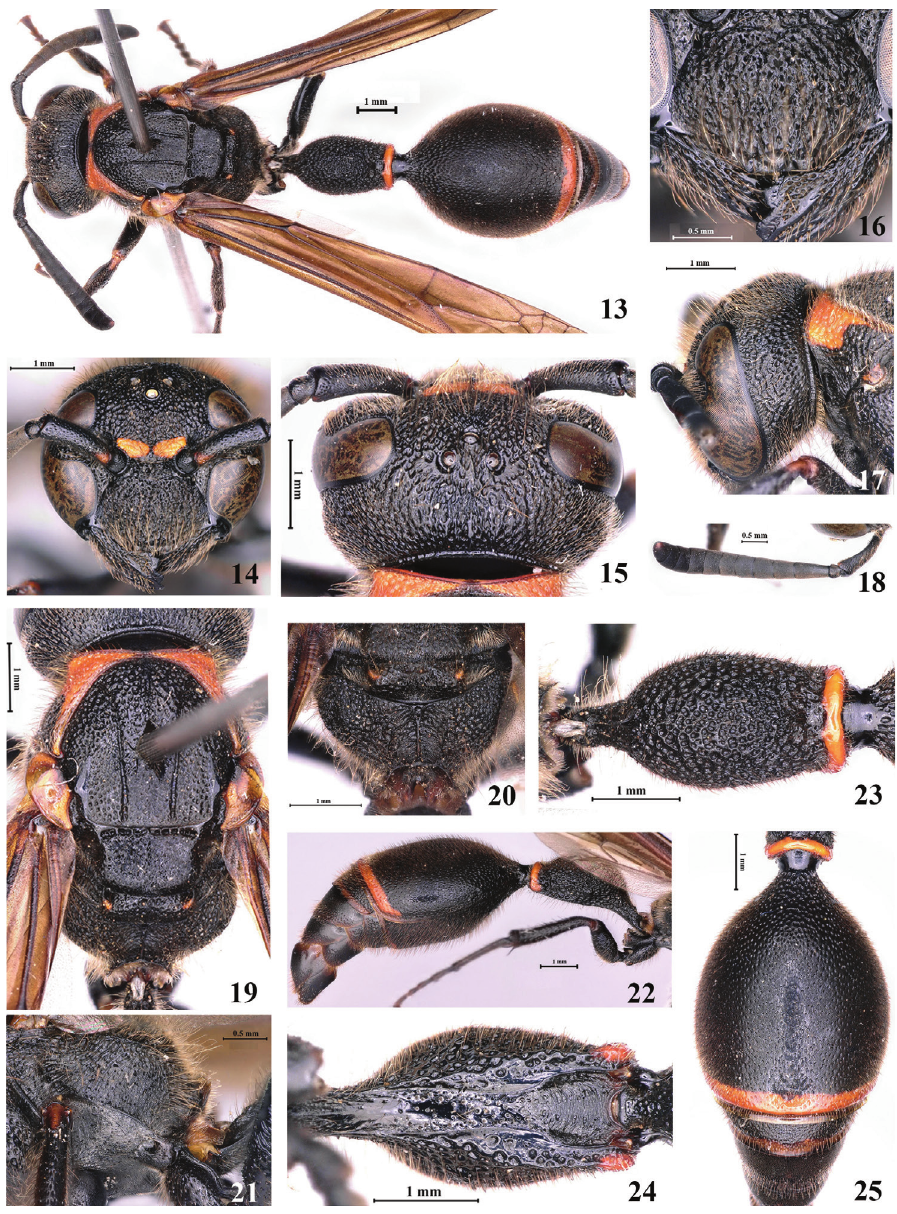
Figures 13–25. Zethus asperipunctatus sp. nov., holotype 13 habitus in dorsal view, ♀ 14 head in frontal view, ♀ 15 vertex, ♀ 16 clypeus, ♀ 17 gena, ♀ 18 antenna, ♀ 19 mesosoma, ♀ 20 propodeum in dorsal view, ♀ 21 propodeum in lateral view, ♀ 22 metasoma in lateral view, ♀ 23 T1, ♀ 24 S1, ♀ 25 T2, ♀ . tudinal carina (Fig. 17); distance from posterior ocelli to apical margin of vertex 1.7× as long as distance from posterior ocelli to inner eye margin (Fig. 15); occipital carina complete (Fig. 15); antennal scape 2.7× as long as its apical width, A3 1.8× as long